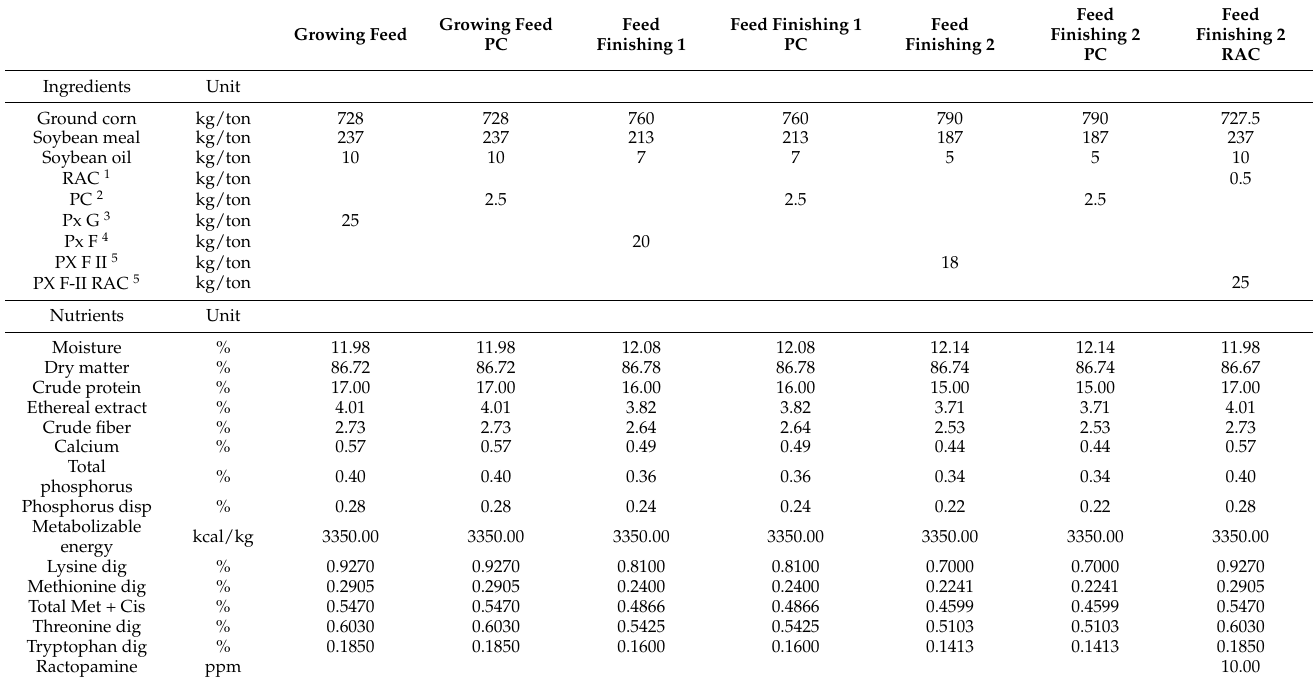
Table 1. Diets used in the evaluation: growth feed, finishing 1, finishing 2, and the addition of additives: phytogenic compound (PC) and ractopamine